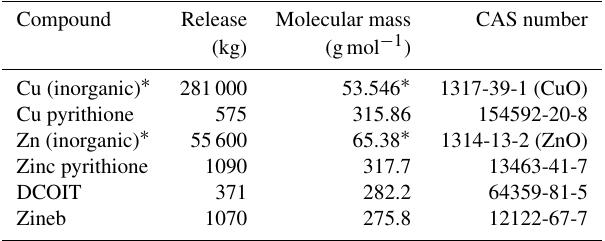
Table 8. Emission totals for antifouling paints in the Baltic Sea area during 2012. These numbers contain the contribution from the com- mercial fleet. The Chemical Abstracts Service (CAS) number is pro- vided for each